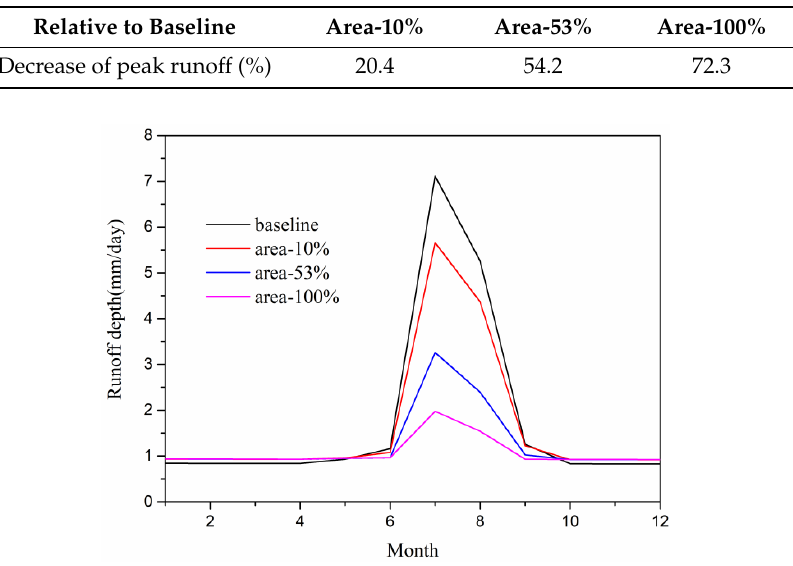
Figure 14. Sensitivity of runoff depth under different glacier area variations (1959–1961).